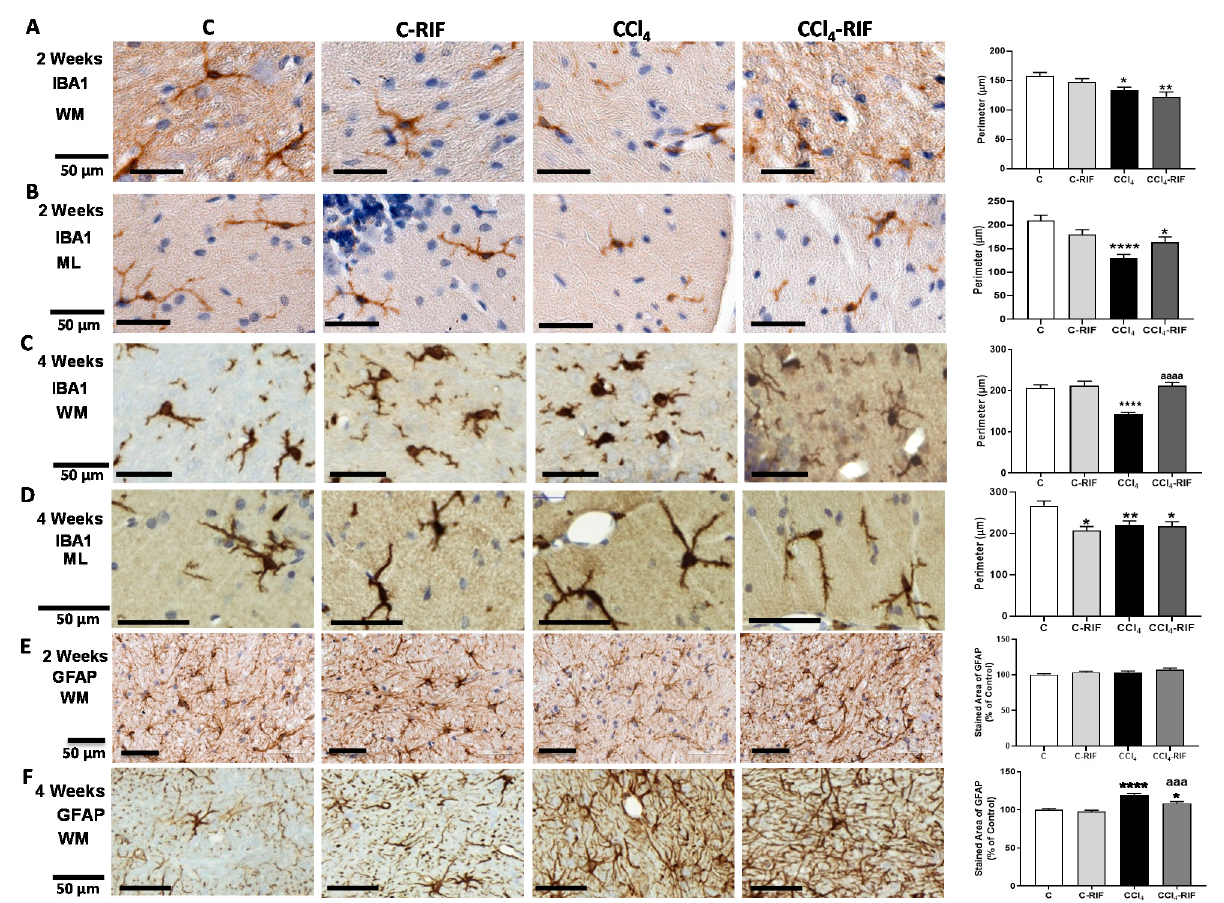
Figure 8. Analysis of microglia and astrocytes activation in cerebellum of rats with mild liver damage. ( A , B ) Representative images and analysis of activation state of microglia in white matter (WM) and molecular layer (ML) at 2 weeks. One-way ANOVA with Tukey’s test was performed to compare all groups (WM F(3,6) = 5.283, p < 0.01; ML F(3,5) = 12.43, p < 0.0001). ( C , D ) Representative images and analysis of activation state of microglia in white matter and molecular layer at 4 weeks. Kruskal–Wallis (K-W statistic) with Dunn’s test was performed. For WM, K-W(4,8) = 45.34, p < 0.0001 and for ML, K- W(4,6) = 15.1, p < 0.01. ( E , F ) Representative images and analysis of activation state of astrocytes in white matter at 2 and 4 weeks. Values are mean ± SEM of 3–5 rats per group. One-way ANOVA with Tukey’s test was performed to compare all groups at 2 weeks (F(3,14) = 1.536, p > 0.05) and Welch’s ANOVA was performed at 4 weeks (W(3,11) = 23.91, p < 0.0001). Values significantly different from control rats are indicated by asterisks and from CCl 4 rats by a. * p < 0.05, ** p <